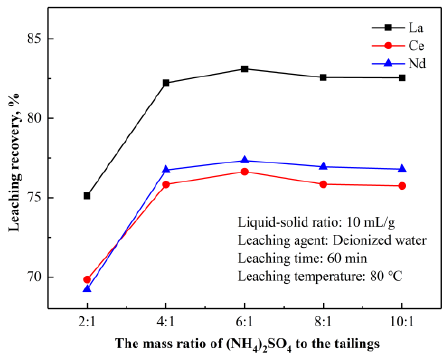
Figure 18. Effect of the mass ratio on the leaching recoveries of La, Ce, and Nd.